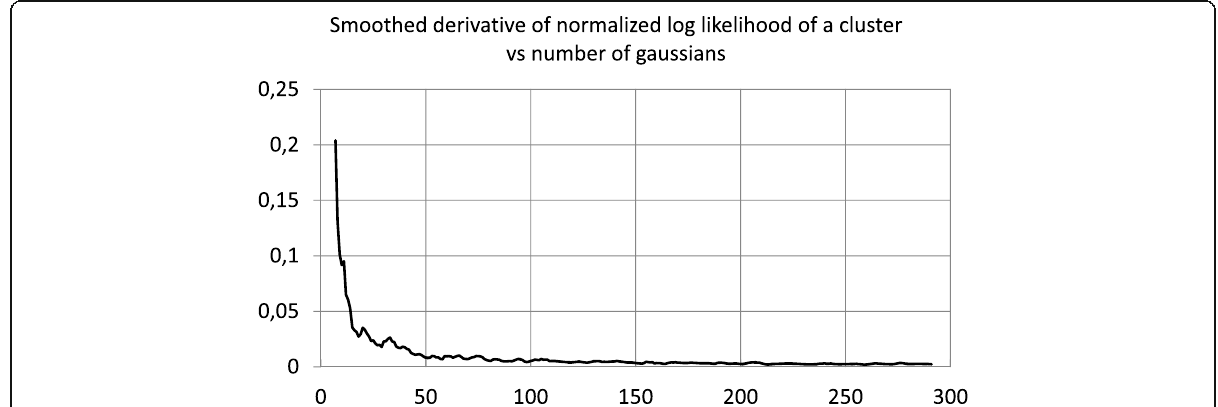
Fig. 8 Smoothed derivative of normalized log-likelihood of a cluster versus the number of Gaussians used to train it. The derivative changes abruptly for a low number of Gaussians and remains constant after 50 Gaussians